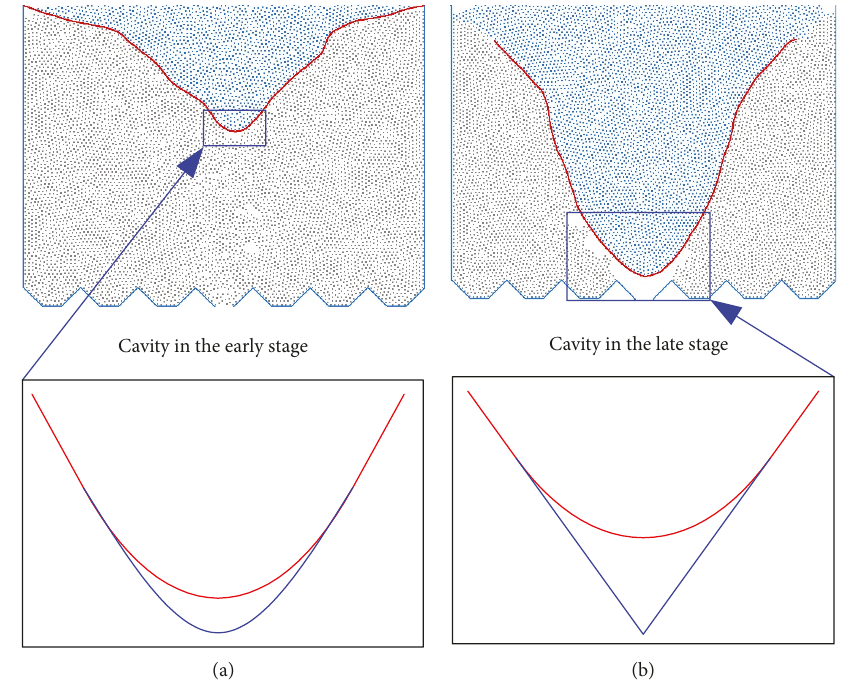
Figure 11: Morphology evolution of the